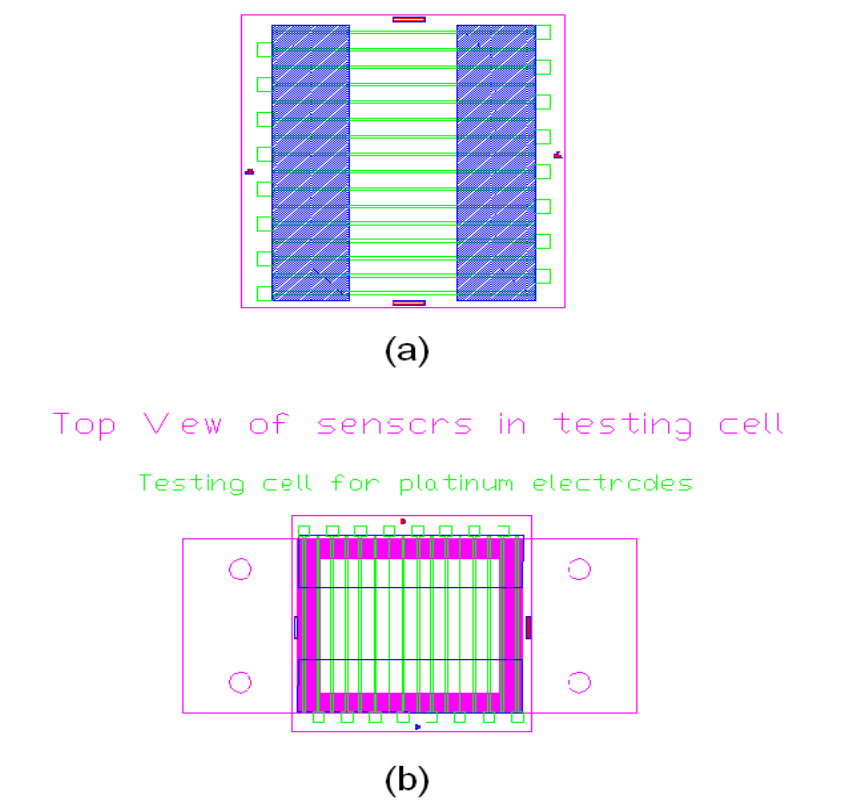
O insulation oxide 2 3